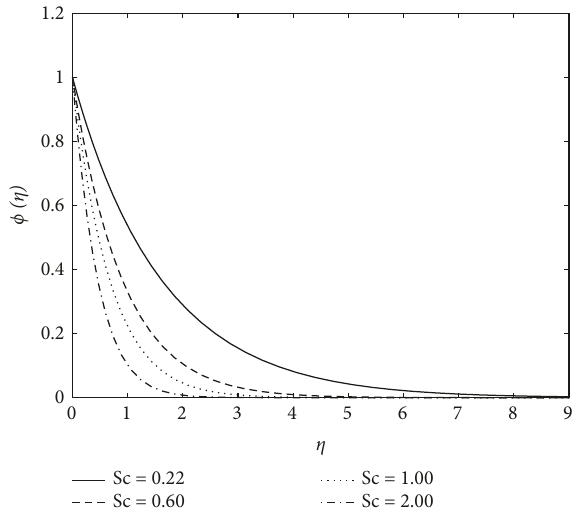
Figure 16: Change in the value of ∅ ( η ) for different values of Sc.